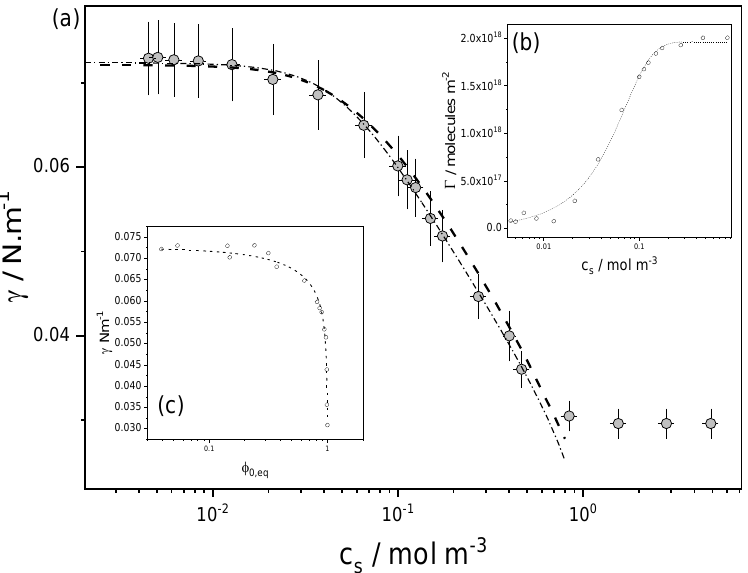
Figure 3. ( a ) Surface tension isotherm for Gemini 12-2-12. The lines are two different fittings with Equation (2), see Discussion section for details. ( b ) Equilibrium surface concentration as a function of bulk concentration calculated from Equation (2) ( c ) Surface tension as a function of surfactant area fraction at equilibrium (see Equation (2)).